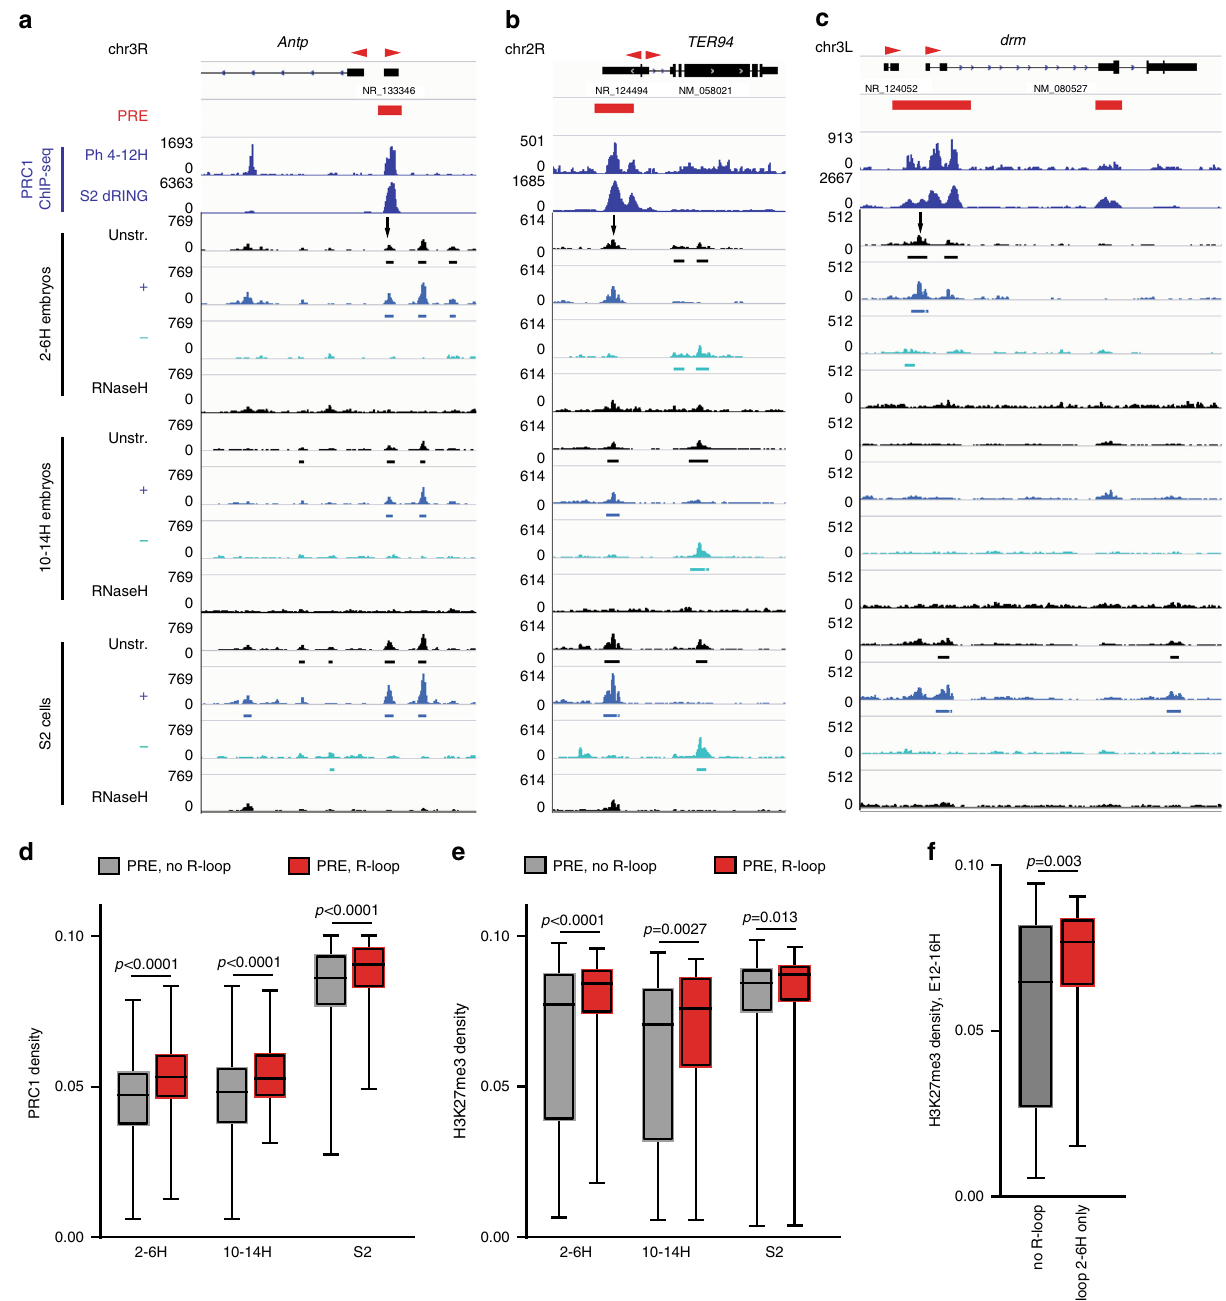
Fig. 1 R-loops form at Drosophila PREs and correlate with a repressed state. a – c DRIP-seq traces showing R-loop formation at PREs bound by PRC1 components (arrows) in 2 – 6H and 10 – 14H Drosophila embryos (Ph), and in S2 cells (dRING). RNaseH-treated samples are negative controls. “ Unstr ” indicates all R-loops, while + and – indicate strand speci fi c tracks; direction refers to the DNA in the RNA – DNA hybrid. Called peaks are indicated under the traces. Red arrowheads above genes indicate direction of annotated transcripts. d , e Median normalized intensity of PRC1 components ( d ), or H3K27me3 ( e ) over PREs with or without R-loops. 2 – 6H and 10 – 14H R-loop data are compared with Ph at 4 – 12H and H3K27me3 at 4 – 8H and 12 – 16H respectively. S2 cell R-loop data are compared with dRING. Whiskers show min. to max. f Median normalized intensity of H3K27me3 at 12 – 16H over PREs where R-loop formation is detected in 2 – 6H but not in 10 – 14H compared to PREs with no R-loops detected at either stage. p -values are for